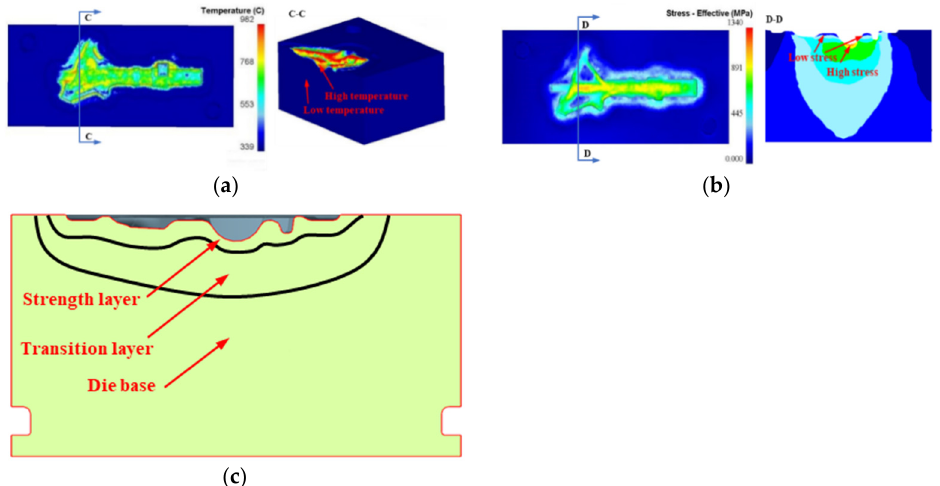
Figure 9. Stress and temperature field and gradient structure design: ( a ) Stress field; ( b ) Temperature field; ( c ) Gradient structure.